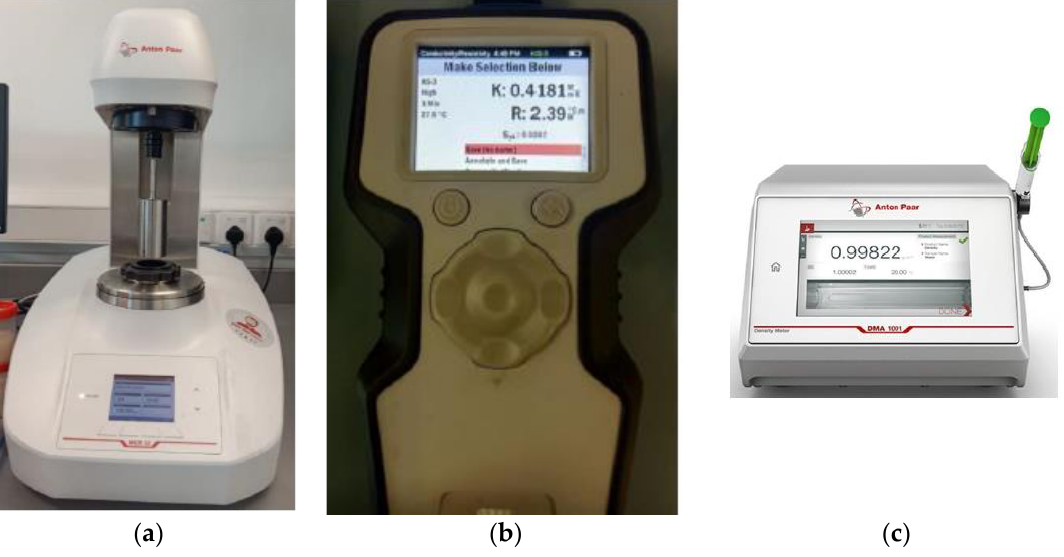
Figure 1. ( a ) Anton Paar rheometer, ( b ) TEMPOS, ( c ) Anton-Paar GmbH density meter.